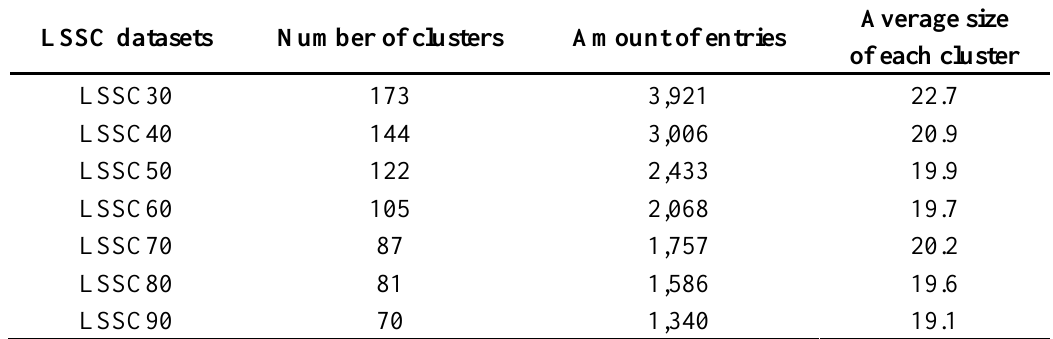
Table 1. The numbers of clusters and entries of the large sequence similarity clusters (LSSC) datasets. LSSC datasets Number of clusters Amount of